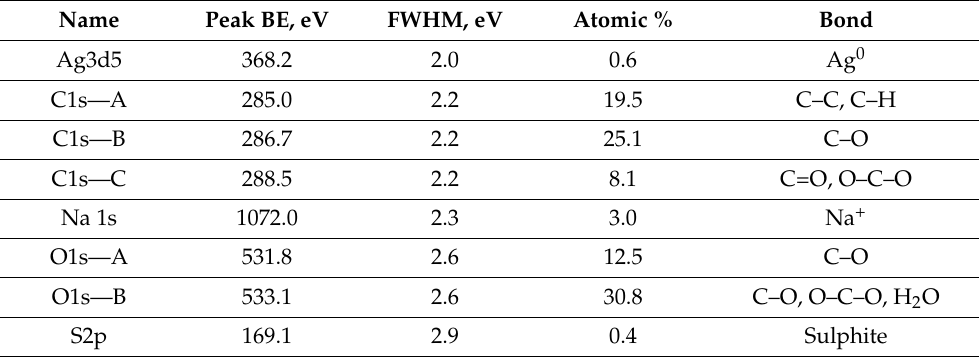
Table 1. XPS quantification and main peaks BE values of